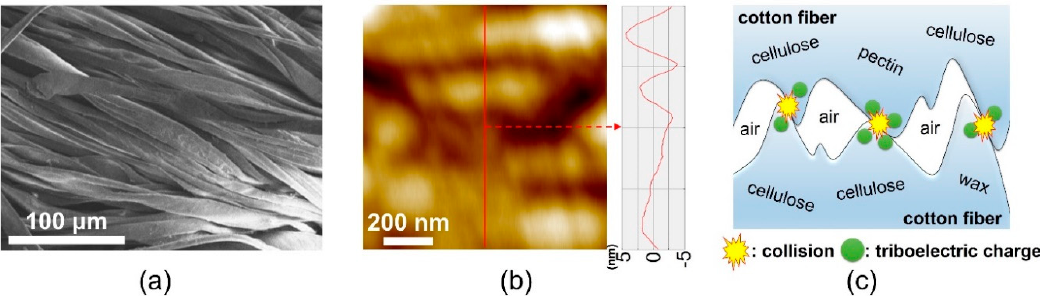
Figure 2. ( a ) Scanning electron microscopy image of cotton fibers, ( b ) atomic force microscopy image of a cotton fiber, and ( c ) a schematic of collisions among the molecules in the surface microstructures of the cotton